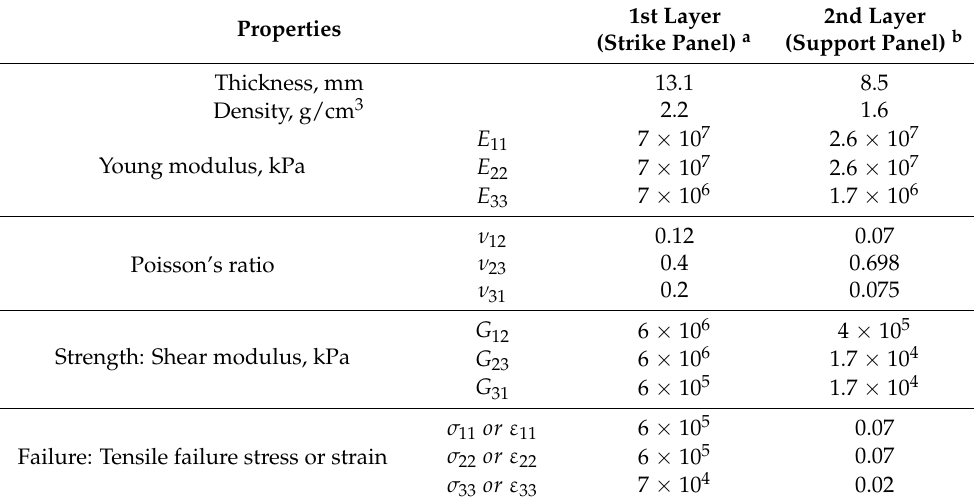
Figure 9. Numerical simulations results obtained for an impacted composite over time. Table 3. A summary of material properties for the multilayered composites